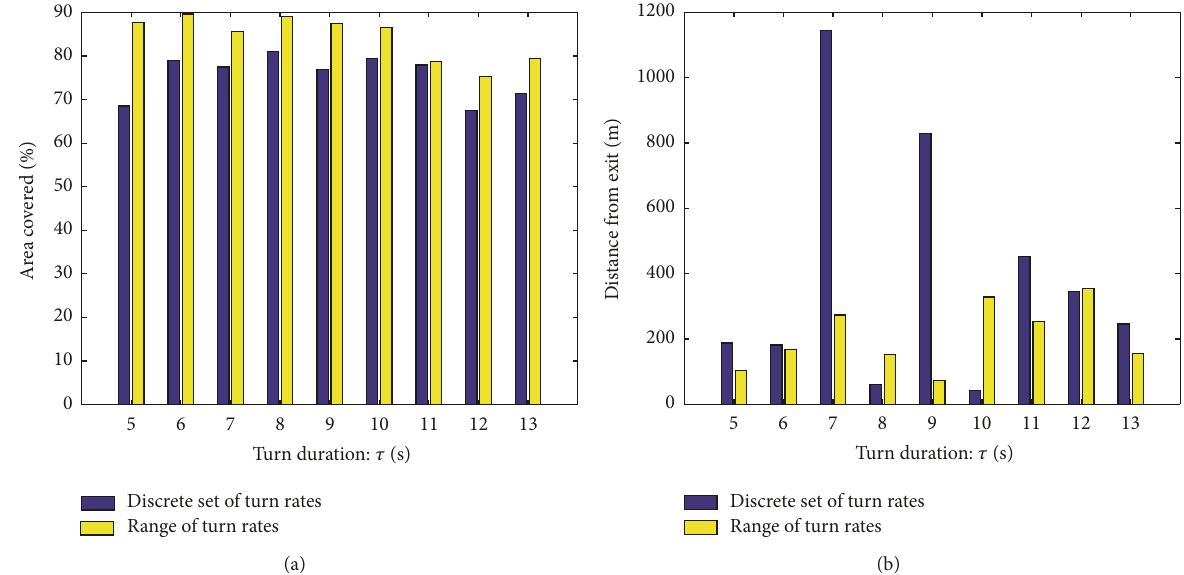
Figure 12: Performance of discrete set and range of turn rates: (a) percent of area covered and (b) distance of the vehicle from the desired exit state at the end of the mission.